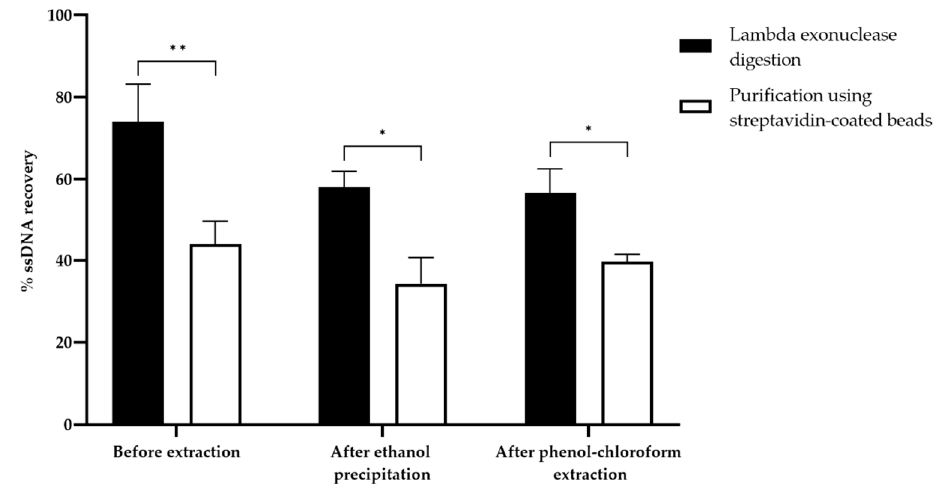
Figure 8. Histogram of ssDNA recovery quantified by gel electrophoresis for the two-ssDNA generation methods before and after two types of purification. Asterisks represent significant differences according to Student’s t -test (*: threshold of 0.01 or **: threshold of